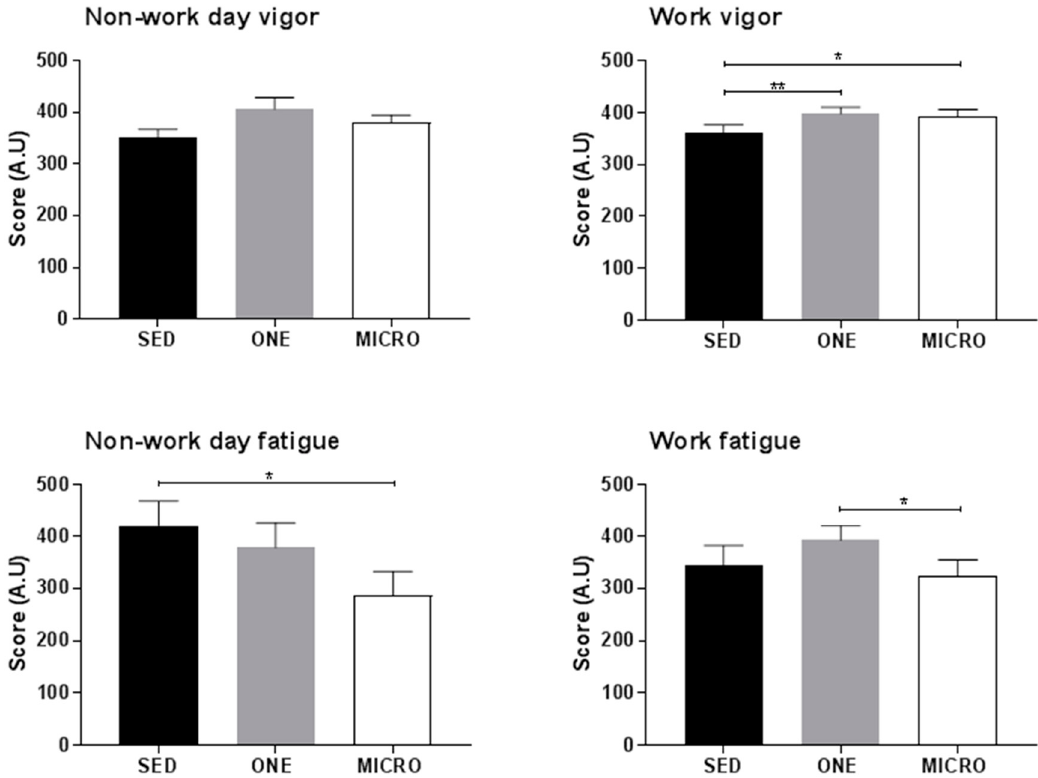
Figure 4. Self-perceived fatigue and vigor. At the end of each study day participants rated their self-perceived feeling of fatigue and vigor (arbitrary unit). SED, sedentary condition; ONE, one-bout intervention; MICRO, microbouts intervention. * p < 0.05, ** p < 0.01 vs. sedentary control condition.